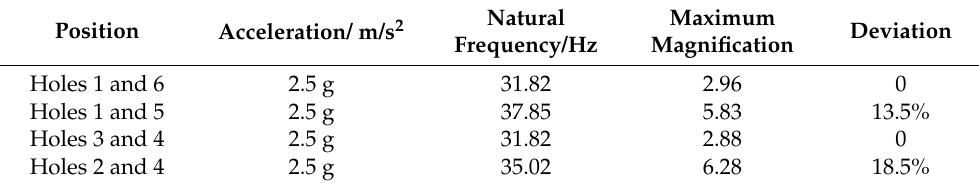
Table 5. Influence of deviation on vibration isolation